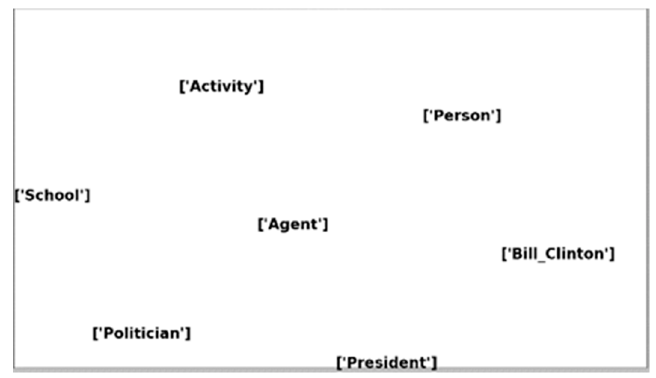
Figure 2 Visualization of DBpedia types for the entity Bill_Clinton. Figure 2. Visualization of DBpedia types for the entity